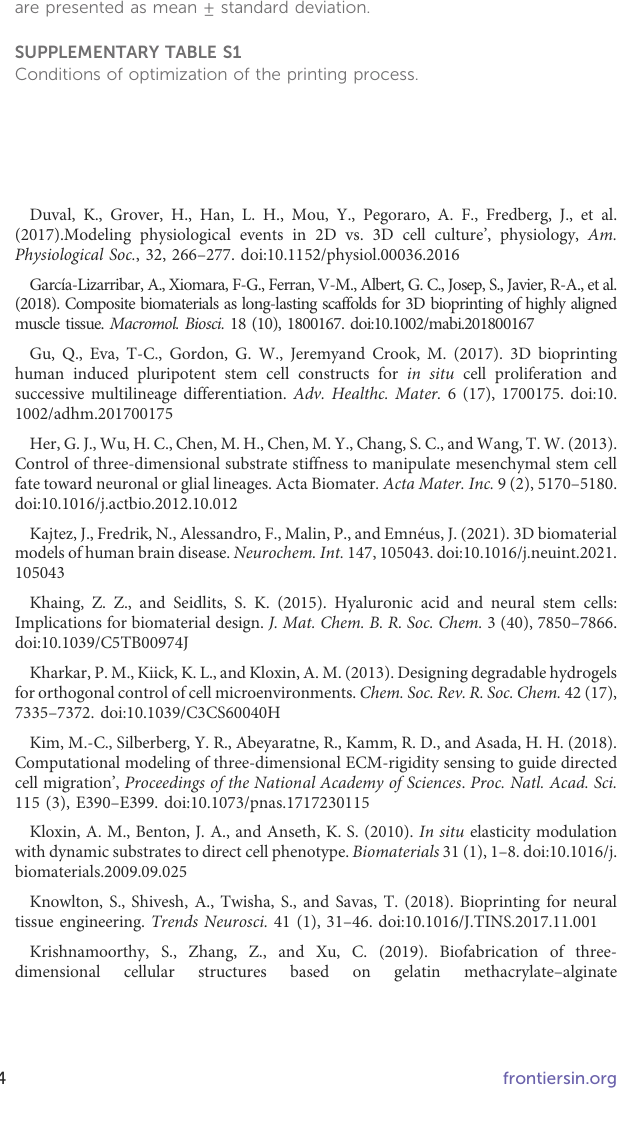
SUPPLEMENTARY FIGURE S1 Optimization of the polymer concentration through viability and immuno fl uorescence assays. (A) Representative confocal images of the viability assaysofdifferentpolymerconcentrationswith3%GelMA, 0 – 0.5% AlgMA, and 2.5 – 5% HA. Nuclei are stained blue, calcein AM in green represents the live cells, and EthD-1 in red represents the dead cells (scale bar 100 µm). (B) Representative confocal images of immuno fl uorescence assay of different polymer concentrations with 3% GelMA, 0 – 0.5% AlgMA, and 2.5 – 5%HA. Progenitor markernestin isstained ingreen,neuronmarker β -III tubulin is stained in red, and nuclei are stained in blue (scale bar 100 µm). (C) Biomaterial drops on days 1 and 7 of the culture. Black arrows point to the less visible drops (scale 2.5 mm). SUPPLEMENTARY FIGURE S2 Optimization of the printing parameters. (A) Images of the printing scaffolds for the three conditions and both hydrogel formulations (scale bar 2.5 mm). (B) Measurement of the fi lament width of the structures printed under the three optimization conditions. Data are presented as mean ± standard deviation. Statistical signi fi cance was calculated using two-way variance analysis (ANOVA) with Turkey ’ s and Sídák ’ s post hoc multiple comparisons test considering **p < 0.01; ***p < 0.001; ****p < 0.0001. SUPPLEMENTARY FIGURE S3 Representationofthequanti fi cationofthenumberofspikesseparatedbythe percentage of cells that presented one, two, or more than two spikes. Data are presented as mean ± standard deviation. SUPPLEMENTARY TABLE S1 Conditions of optimization of the printing